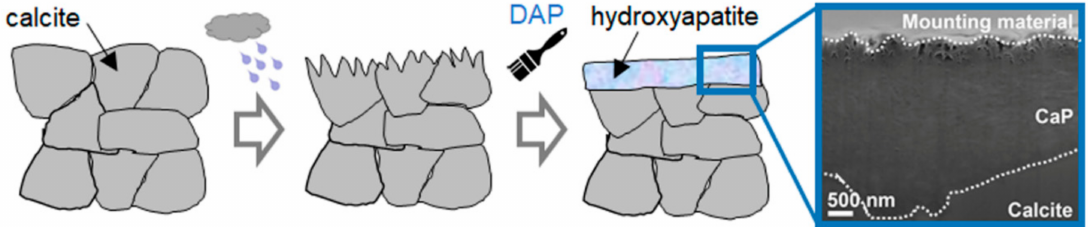
Figure 3. Scheme illustrating the protective action of the phosphate treatment, with an example of a focused ion beam (FIB) SEM cross section of the protective layer formed over marble.